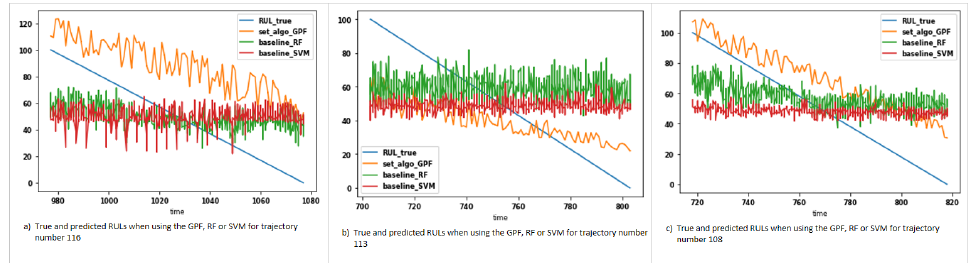
Figure 17. True and predicted values for three different trajectories of the SCU test set when using the GPF, RF, and SVM (cut 100 FC before failure).